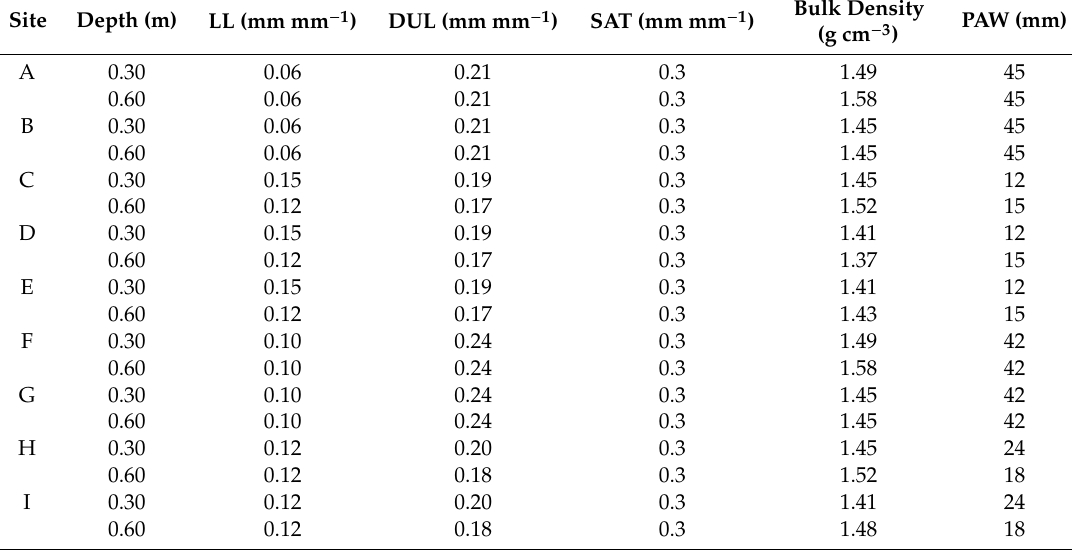
Table 4. Soil water characteristics of studied